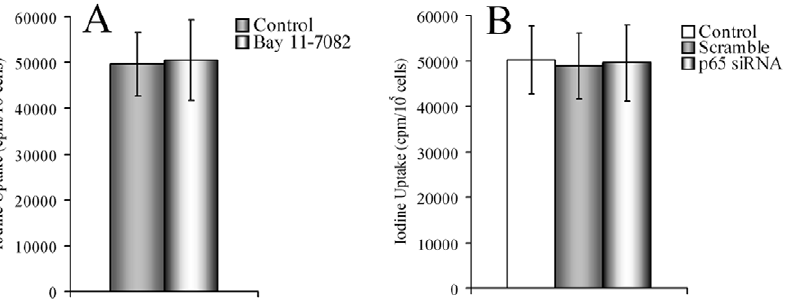
Figure 8. Iodide uptake assay. (A) KTC-1 cells were left untreated or treated with Bay 11-7082 (5 m mol/L) for 24 hours. Then cells were cultured in the present of Na 125 I (37 KBq/mL) for 1 hour. Afterwards, the cells were washed and cell number was counted. Then radioactivity was measured. ( B ) KTC-1 cells were treated with no oligonucleotide control, scrambled oligonucleotides or p65 siRNA transfection first. Then cells were exposed to Na 125 I, and radioactivity was measured. Similar results were obtained in three independent experiments.